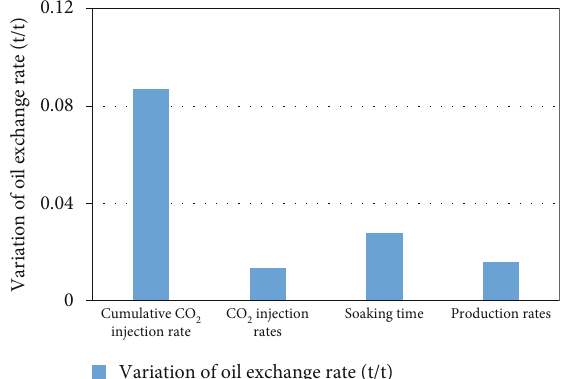
Figure 21: Variation distribution of the oil exchange rate of single- cycle injection-production parameters.